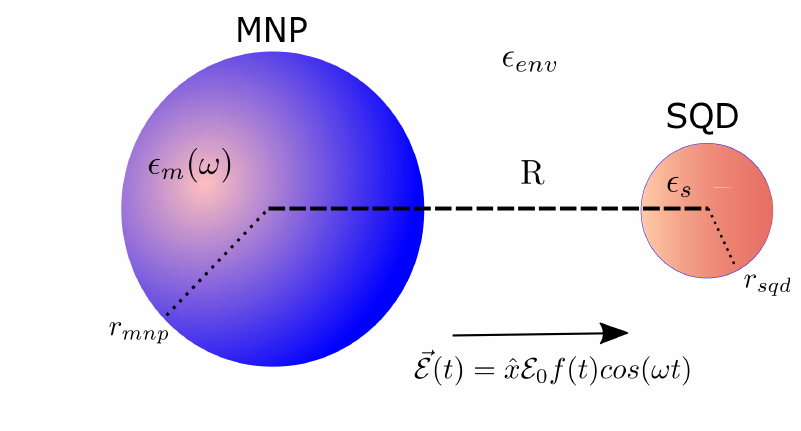
Figure 1. Semiconductor quantum dot–metal nanoparticle coupled